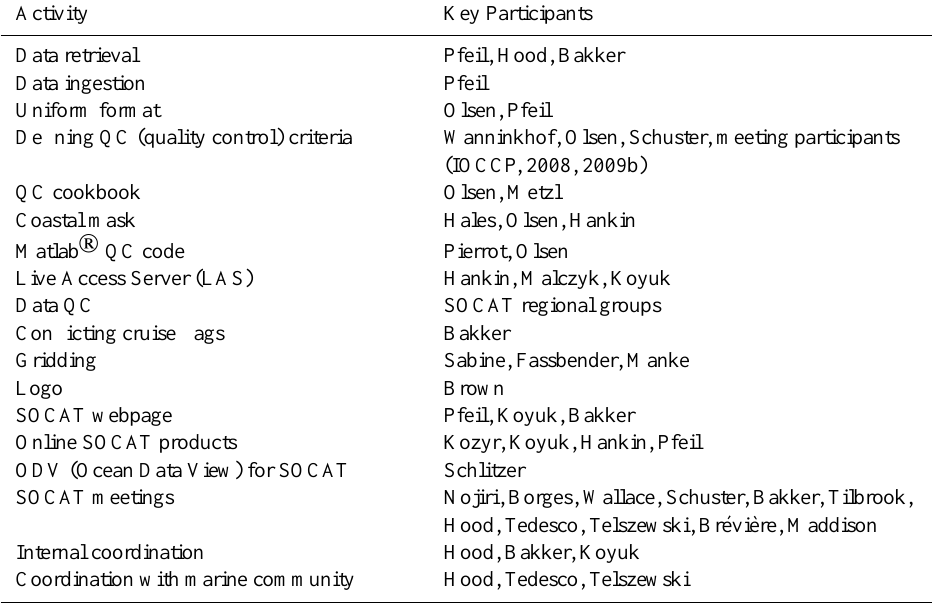
Table 3. Activities and key participants in SOCAT.